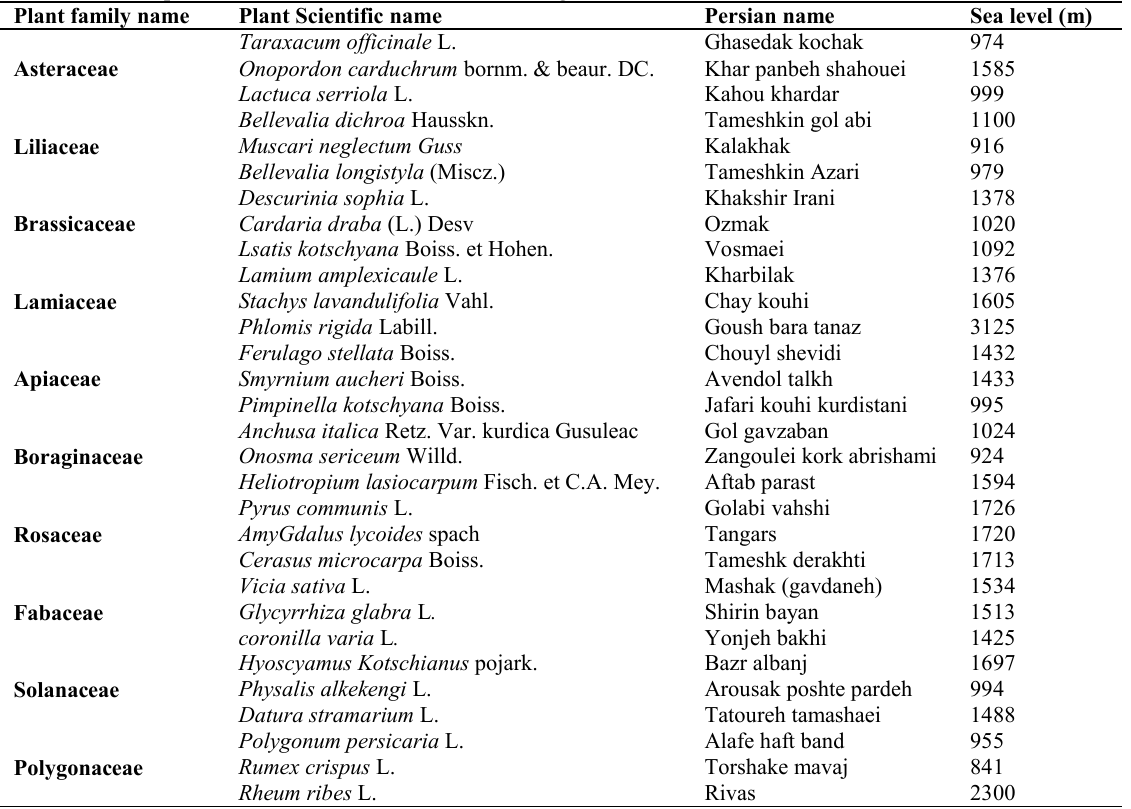
Table 1. List of plants studied in Paveh and Ormanat